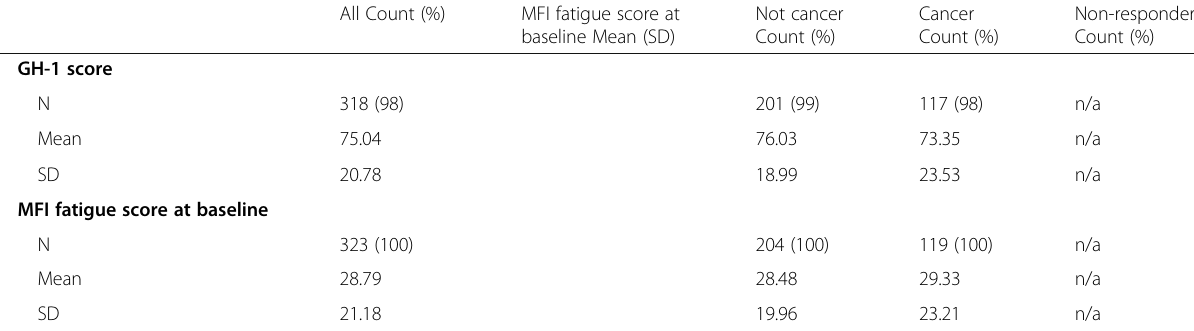
Table 1 Characteristics of women at the time of mammography categorized by cancer diagnosis (Continued)